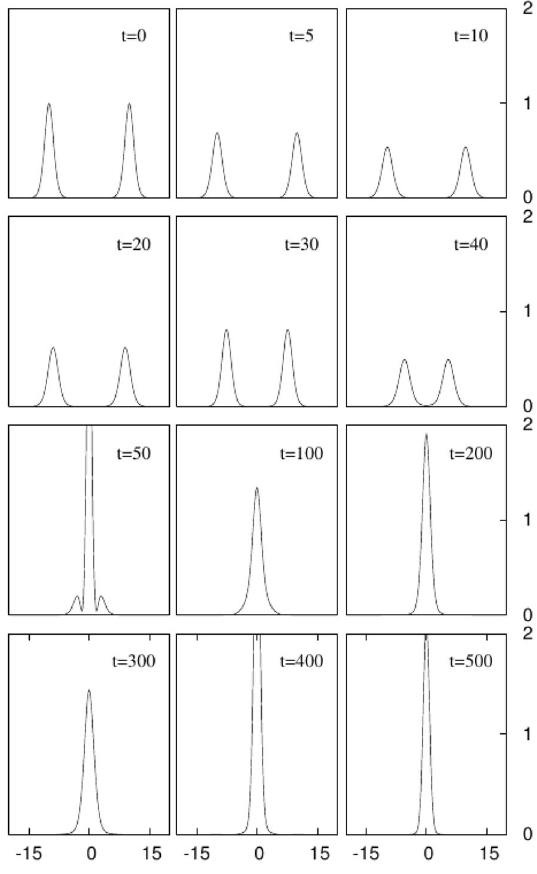
The fi rst simulations of boson stars with full general relativity were reported in Balakrishna (1999), where the gravitational waves were computed for a head-on collision. The general behavior is similar to the one displayed for the Newtonian limit; the stars attract each other through their gravitational interaction and then merge to produce a largely perturbed boson star. However, in this case the merger of the binary was promptly followed by collapse to a black hole, an outcome not possible when working within Newtonian gravity instead of general relativity. Unfortunately, very little detail was given on the dynamics.